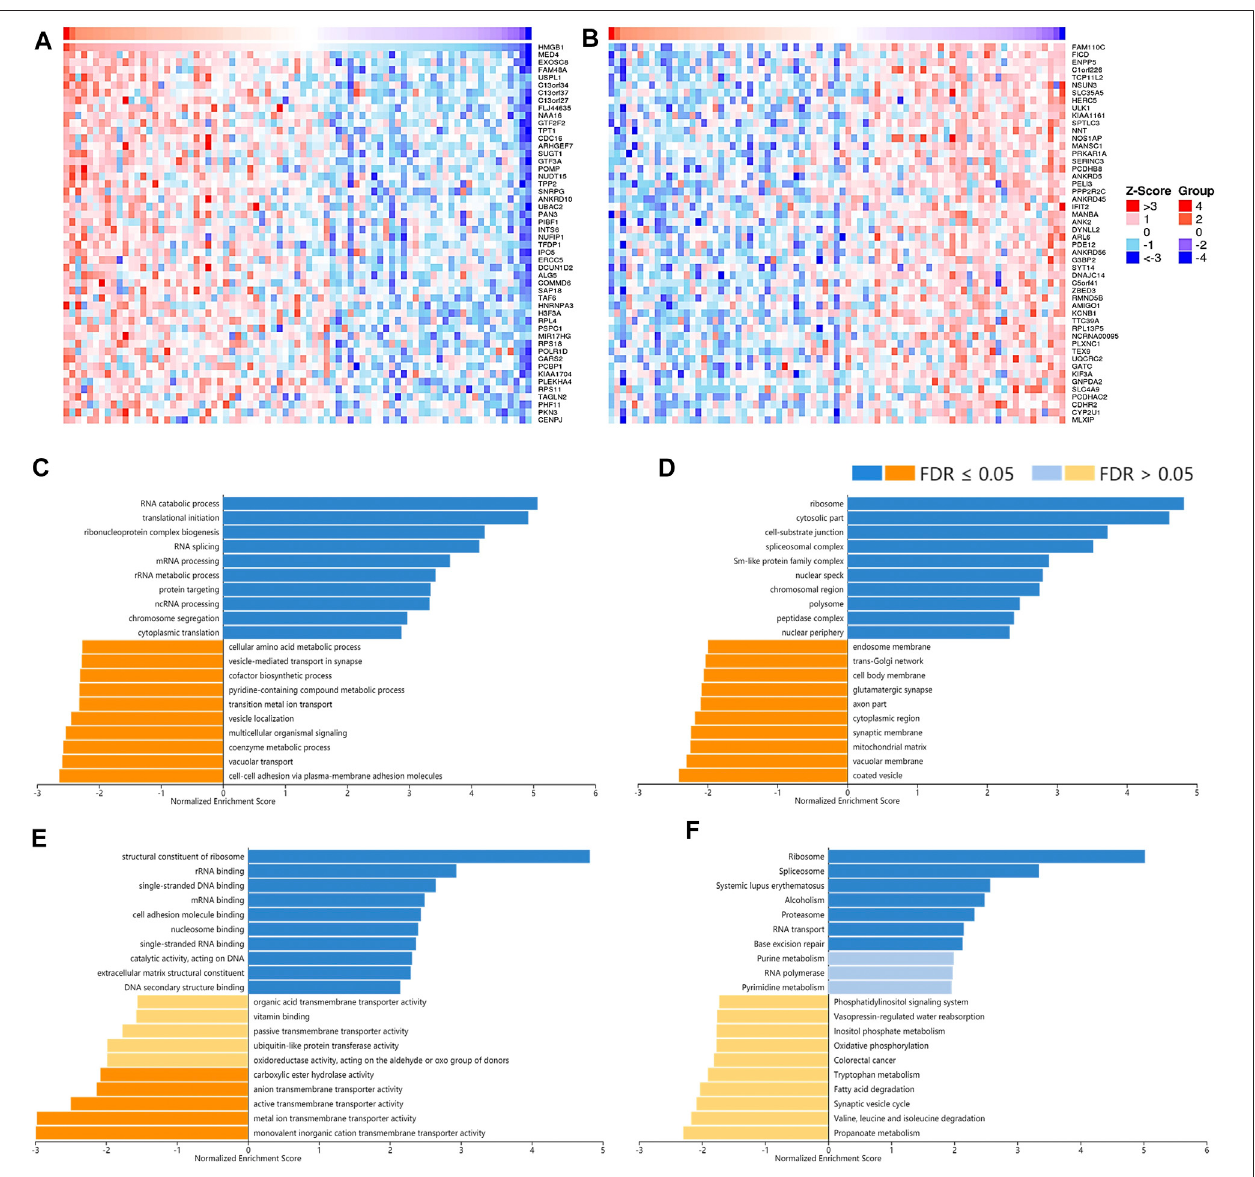
FIGURE 7 | The corrected genes of High Mobility Group Box 1 (HMGB1) in ACC and GSEA results. The top 50 genes signi fi cantly (A) positively and (B) negatively correlated with HMGB1 in ACC (LinkedOmics). The top 20 signi fi cantly enriched (C) GO-BP, (D) GO-CC, (E) GO-MF, and (F) KEGG pathway terms of HMGB1 correlated genes based on GSEA. A bar represents a normalized enrichment score for a term, which in orange or blue represents negatively or positively enriched, respectively.